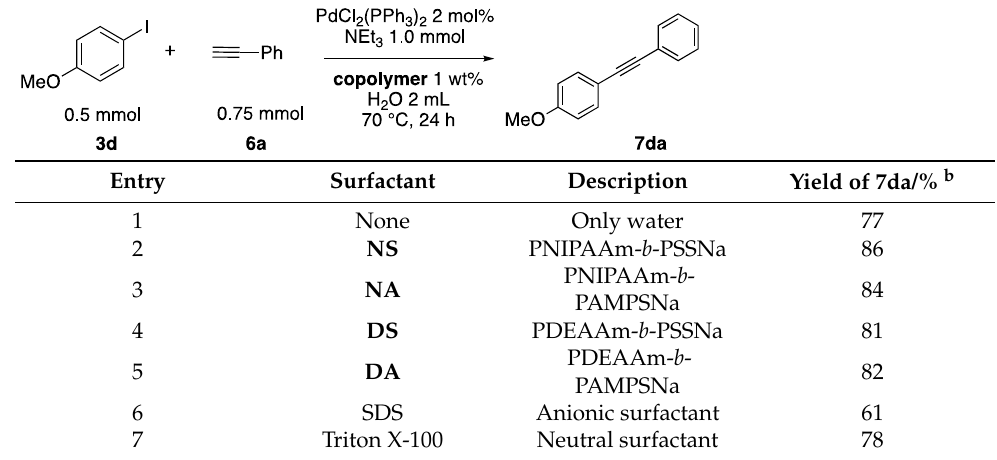
Table 6. Copper-free Sonogashira coupling in water with surfactants a .